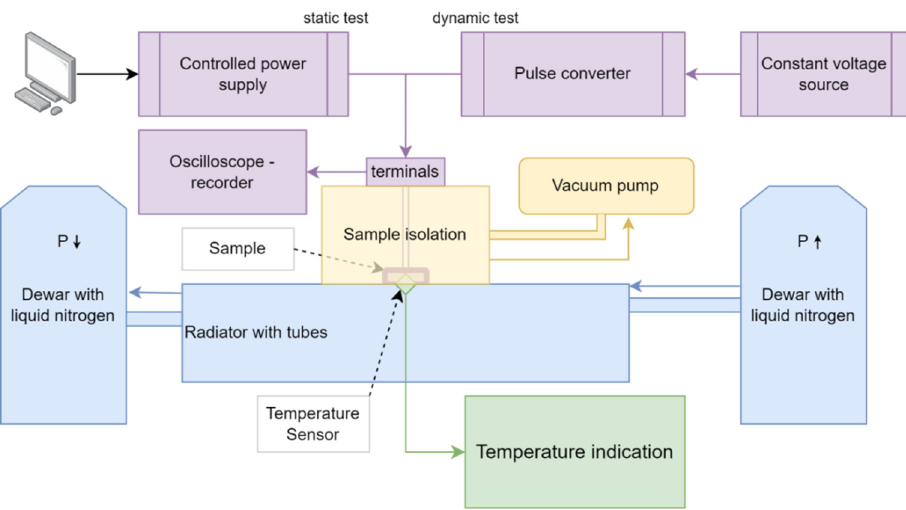
Figure 1. Structural diagram of the test bench.